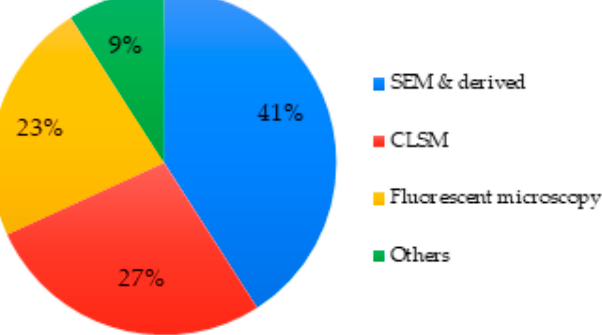
Figure 7. Techniques used to assess cell morphology of MBGs.